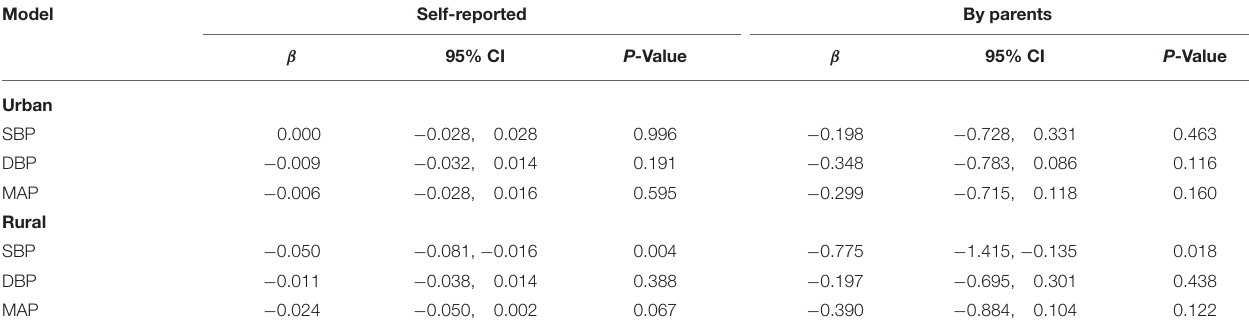
TABLE 3 | Association between extraversion personality traits and the BP level by region in adolescents.